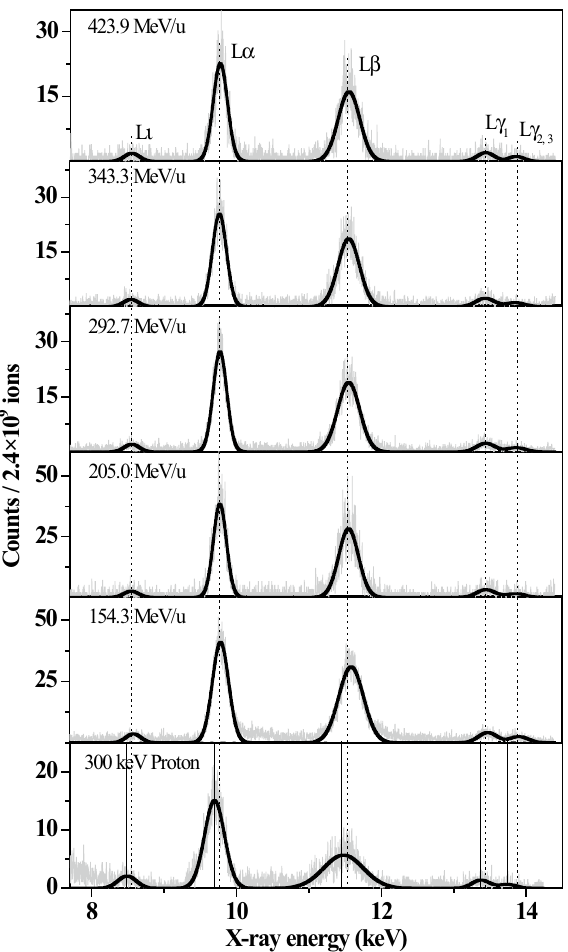
Figure 2. Au L-shell X-ray spectra induced by high energy C 6+ ions with various incident energy, and compared with that induced by